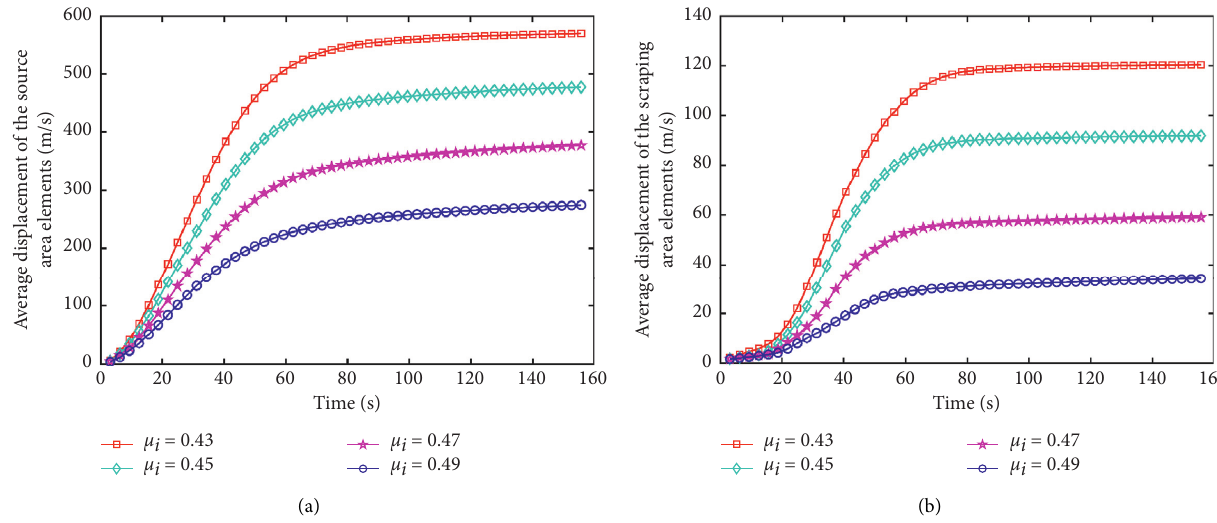
Figure 17: The average displacement of the (a) source area and (b) scraping area elements under different internal friction coefficients.